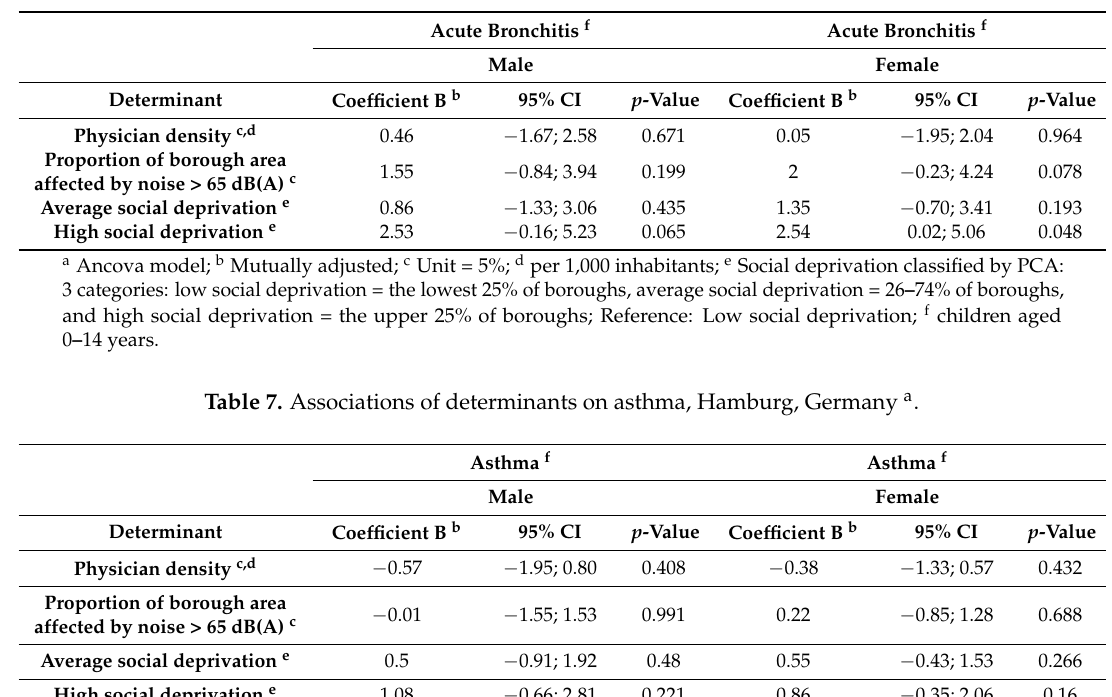
Table 6. Associations of determinants on acute bronchitis, Hamburg, Germany a .